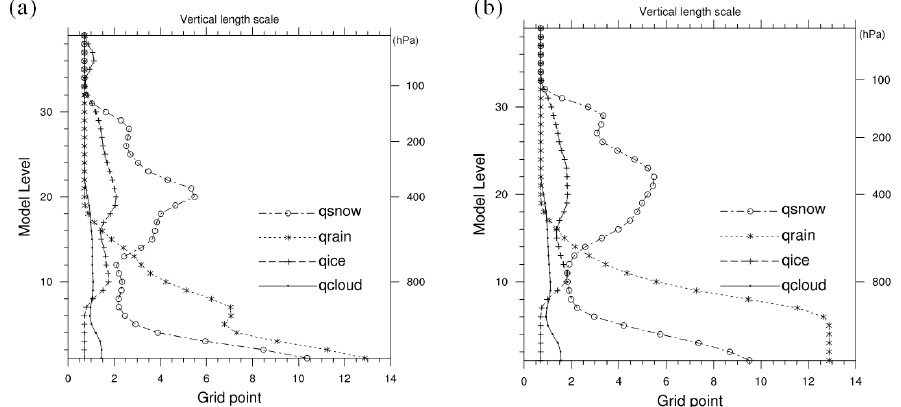
Figure 16. Vertical length scale for the hydrometeors using (a) 50 members and (b) using 5 members. The plots show similar characteristics regardless of the ensemble members (WRF, res. 15km, D-ensemble).